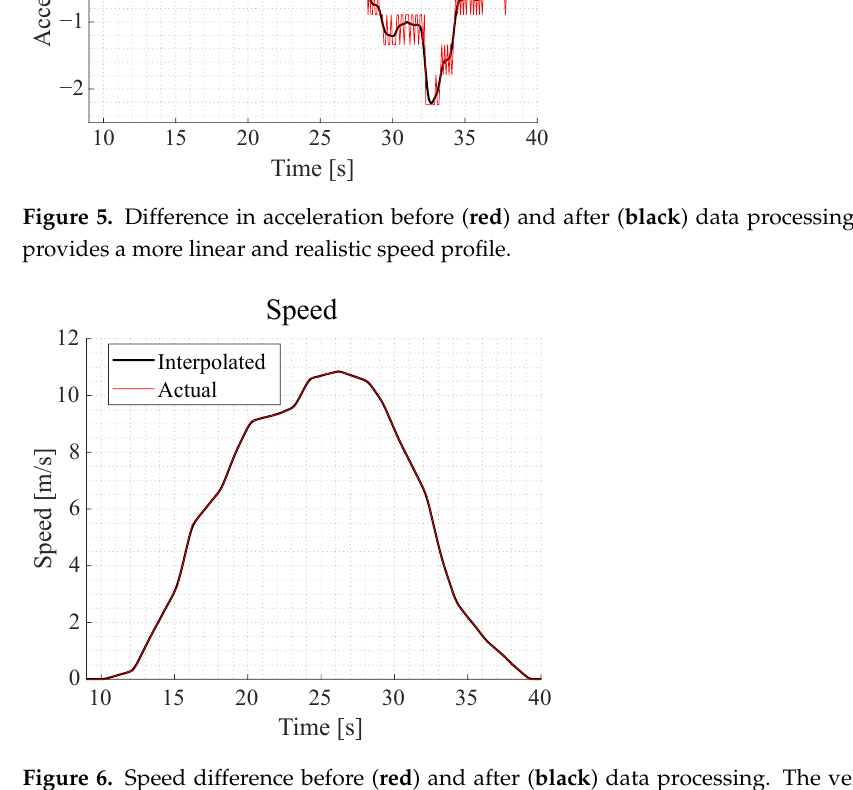
Figure 6. Speed difference before ( red ) and after ( black ) data processing. The velocity profile is practically identical to that before